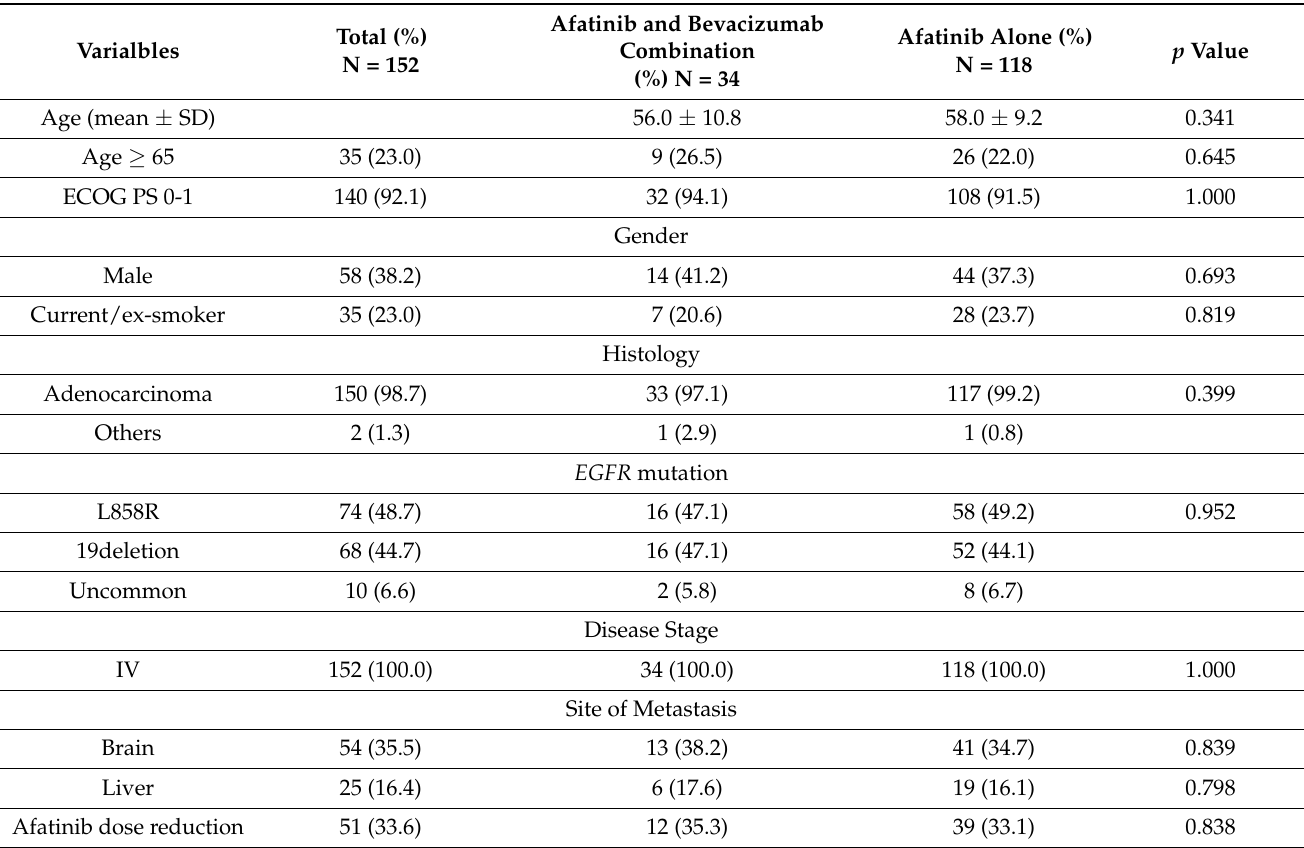
Table 2. Propensity score-matched cohort.